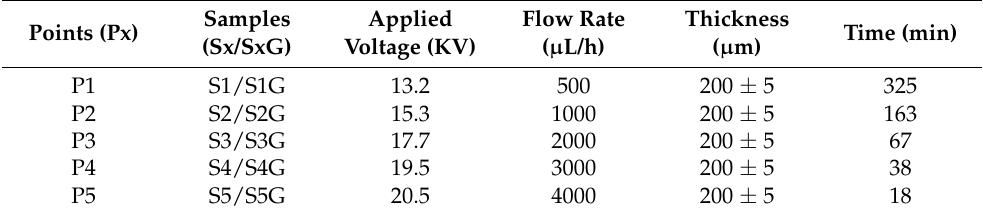
Table 2. Summary of the inputs parameters for the fabrication operational points (P x ) of the electrospun coatings (Sx and SxG) as a function of the flow rate, applied voltage, and deposition time, respectively.